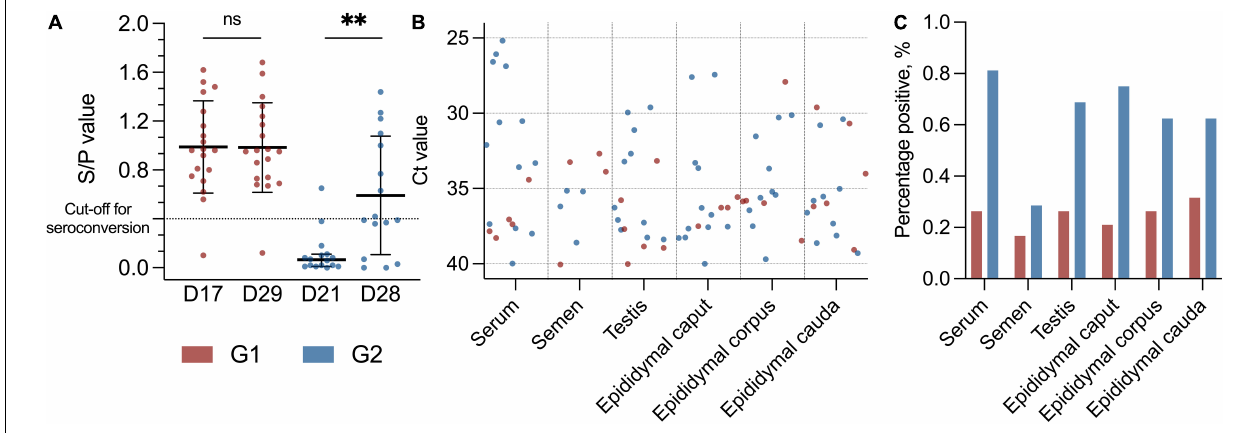
FIGURE 1 | (A) Scatter dot plot with distribution of boars with specific PRRSV antibodies with S/P value on the Y -axis. Black lines indicate mean with SD (D17, D29, and D28) and median with 95% CI (D21), and asterisks (** p < 0.01) and “ns” indicate p -value summary. Cut-off for seroconversion is indicated with a horizontal dotted line. Early seroconversion as G1 (red dots) and late seroconversion as G2 (blue dots). G1 at day 17 (D17) and day 29 (D29) ( p = 0.46). G2 at day 21 (D21) and day 28 (D28) ( p < 0.01, Mdn: 0.40, 95% CI: 0.26–0.69). (B) Scatter dot plot with Ct values ( Y -axis) from the PRRSV-1 RT-PCR with different tissues ( X -axis) from the PRRSV-1-infected boars. Red dots indicate early PRRSV-infected boars (G1), and blue dots indicate later PRRSV-1-infected boars (G2), and sample material is from day 29 and day 28 in the study, respectively. In RT-PCR, 117 data points as negative values are not included. (C) Bar plot with percentage positive results in the PRRSV-1 RT-PCR ( Y -axis) from different tissues ( X -axis). Colours indicate group, with red as G1 and blue as